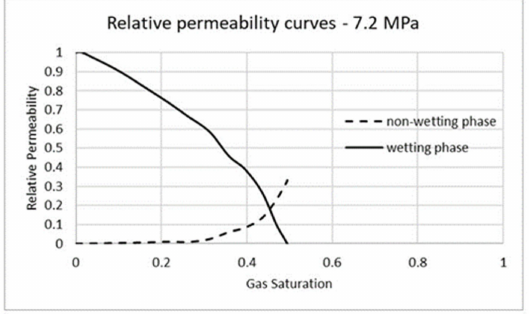
Figure 12. Relative permeability curves at inlet pressure of 7.2 MPa.